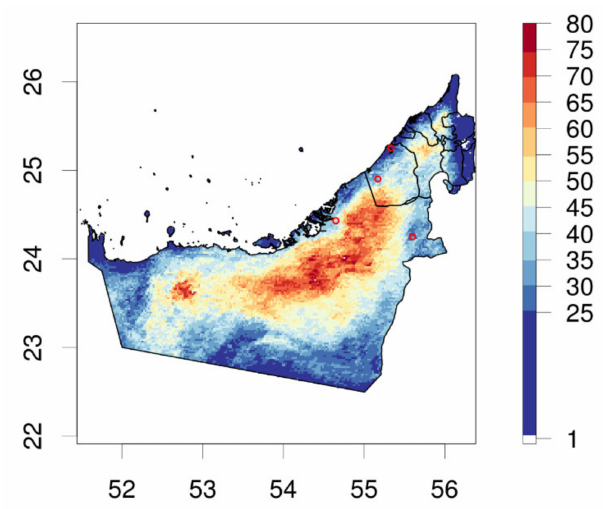
Figure 8. Fog frequency in days for ems(3.9)—low cloud over the 10 month period. Verification sites are indicated by red